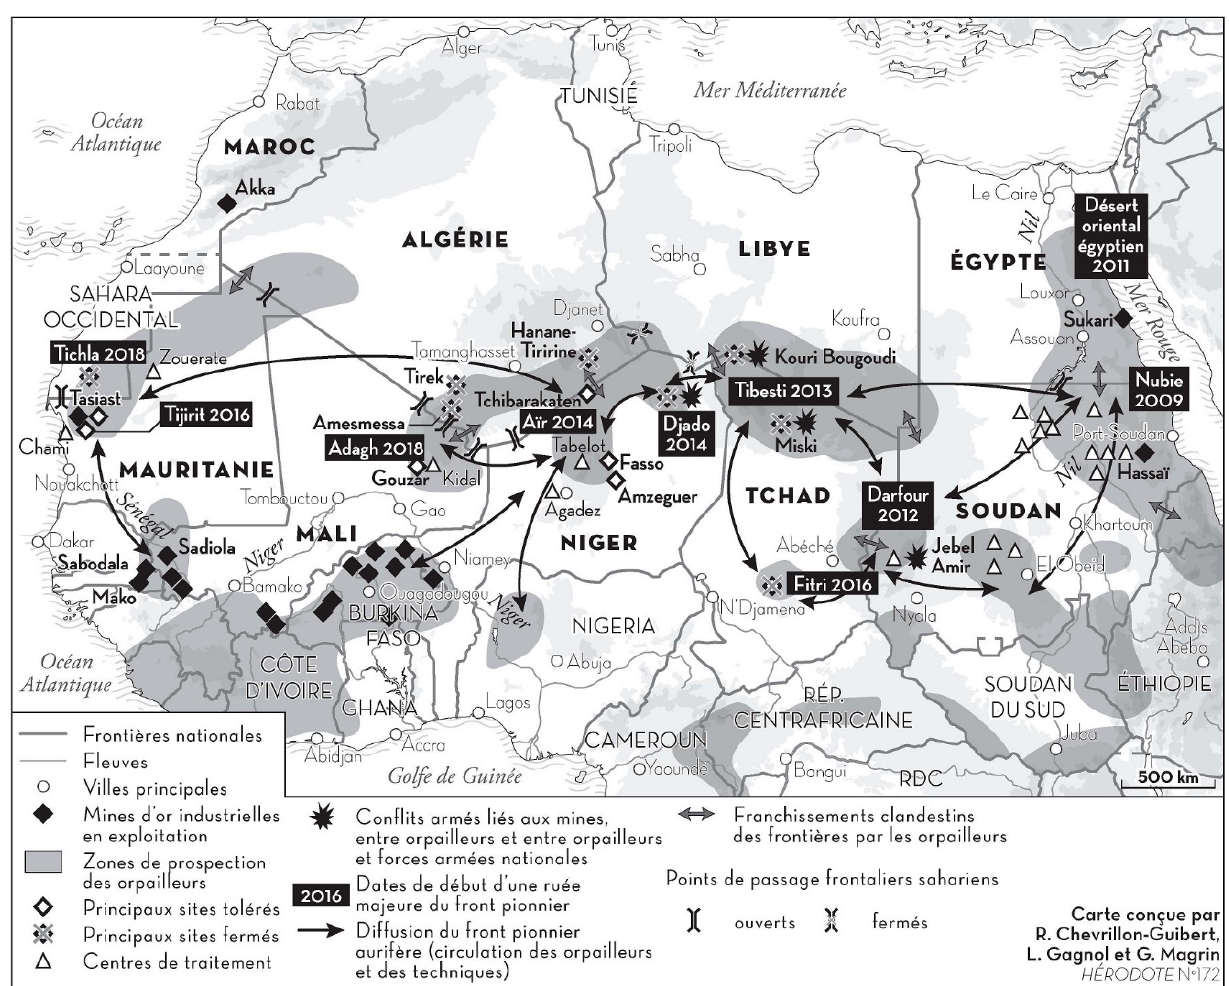
Figure 2. The artisanal front of the gold pioneers in the Saharo-Sahelian space. Note: Reproduced with authors’ permission. Source: Chevrillon-Guibert et al. (2019, p.